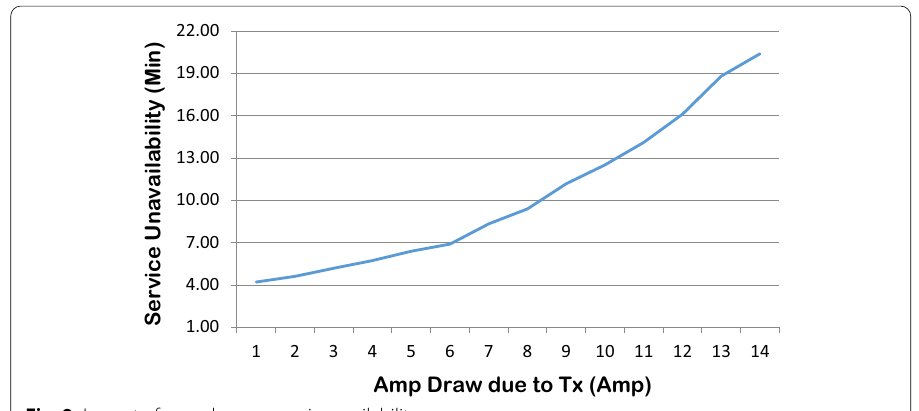
Fig. 9 Impact of amp draw on service